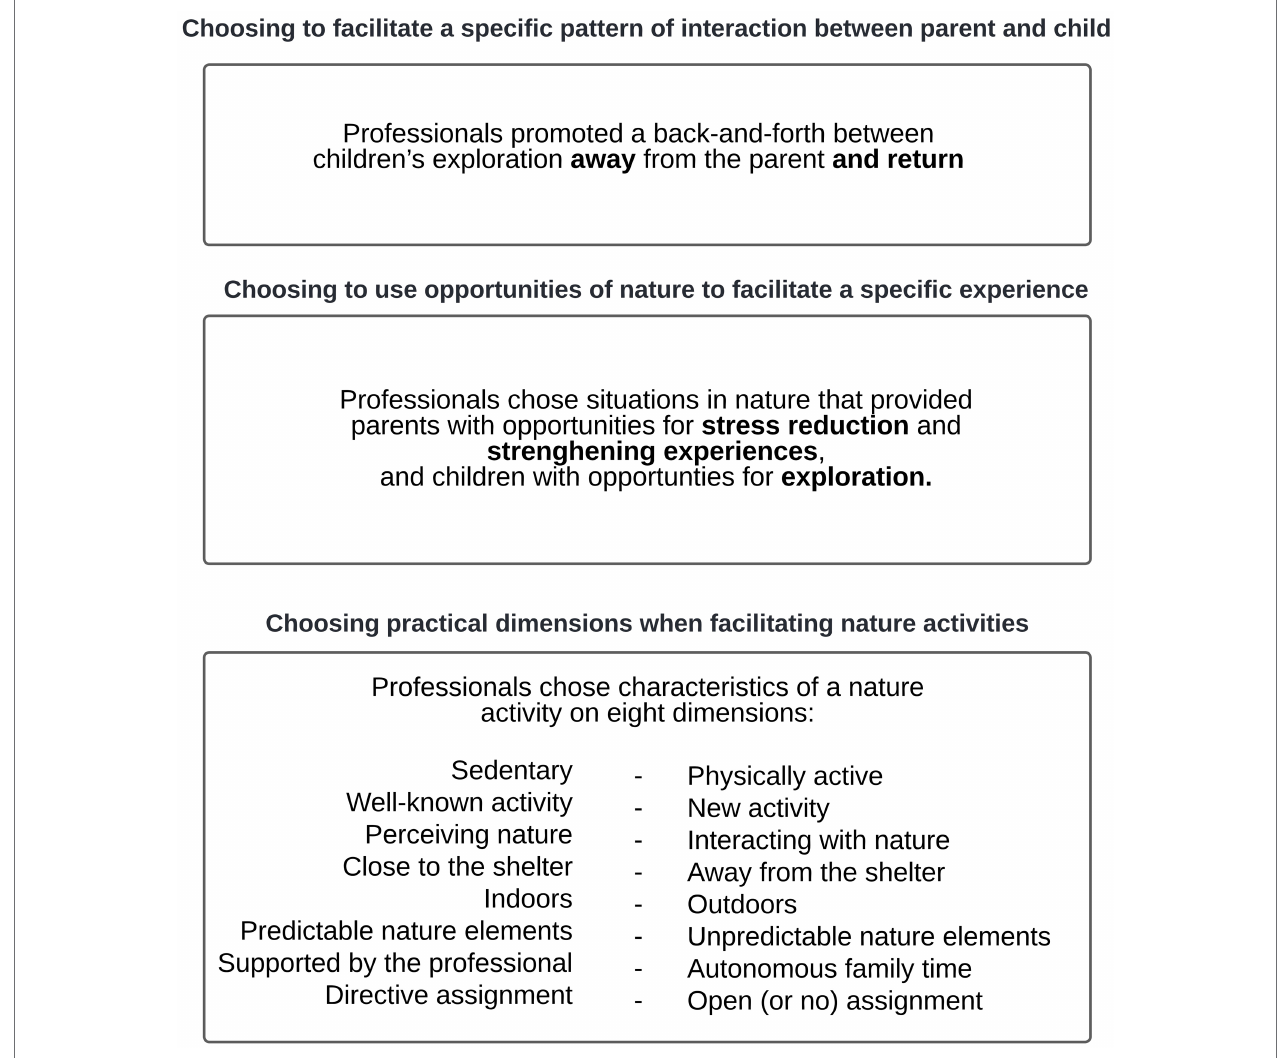
FIGURE 1 | Professional choices in facilitating nature activities for the support of parents in